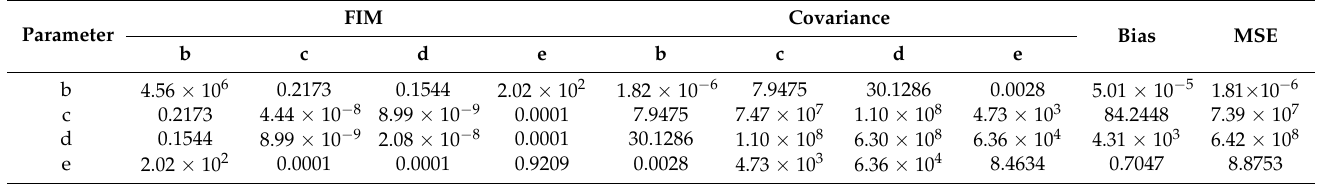
Table 6. Asymptotic approximations of the parameter accuracy metrics of coupled